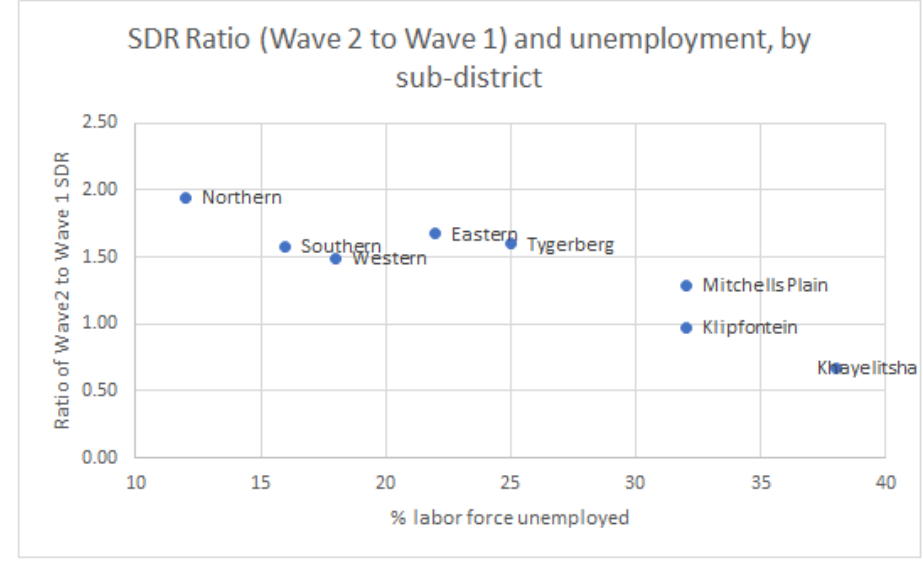
Figure 4. Ratio of Wave 2 to Wave 1 COVID-19 SDRs and percent of labor forced unemployed, by sub-district.